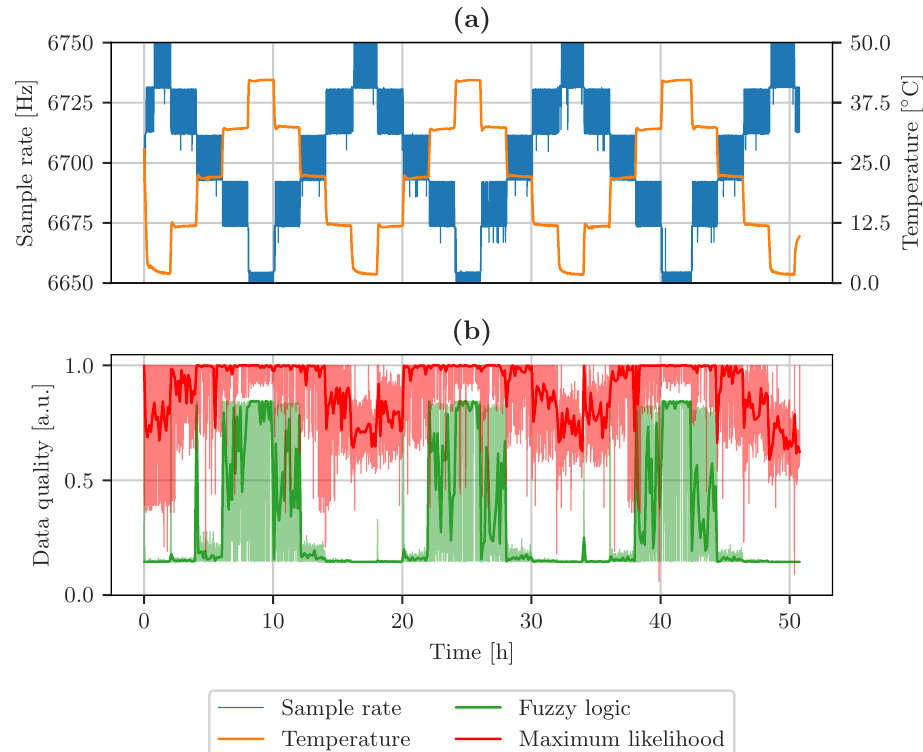
Figure 11. ( a ) Sample rate accuracy of sensor system 3 with changing temperature. ( b ) Data quality indicators based on fuzzy logic and maximum likelihood